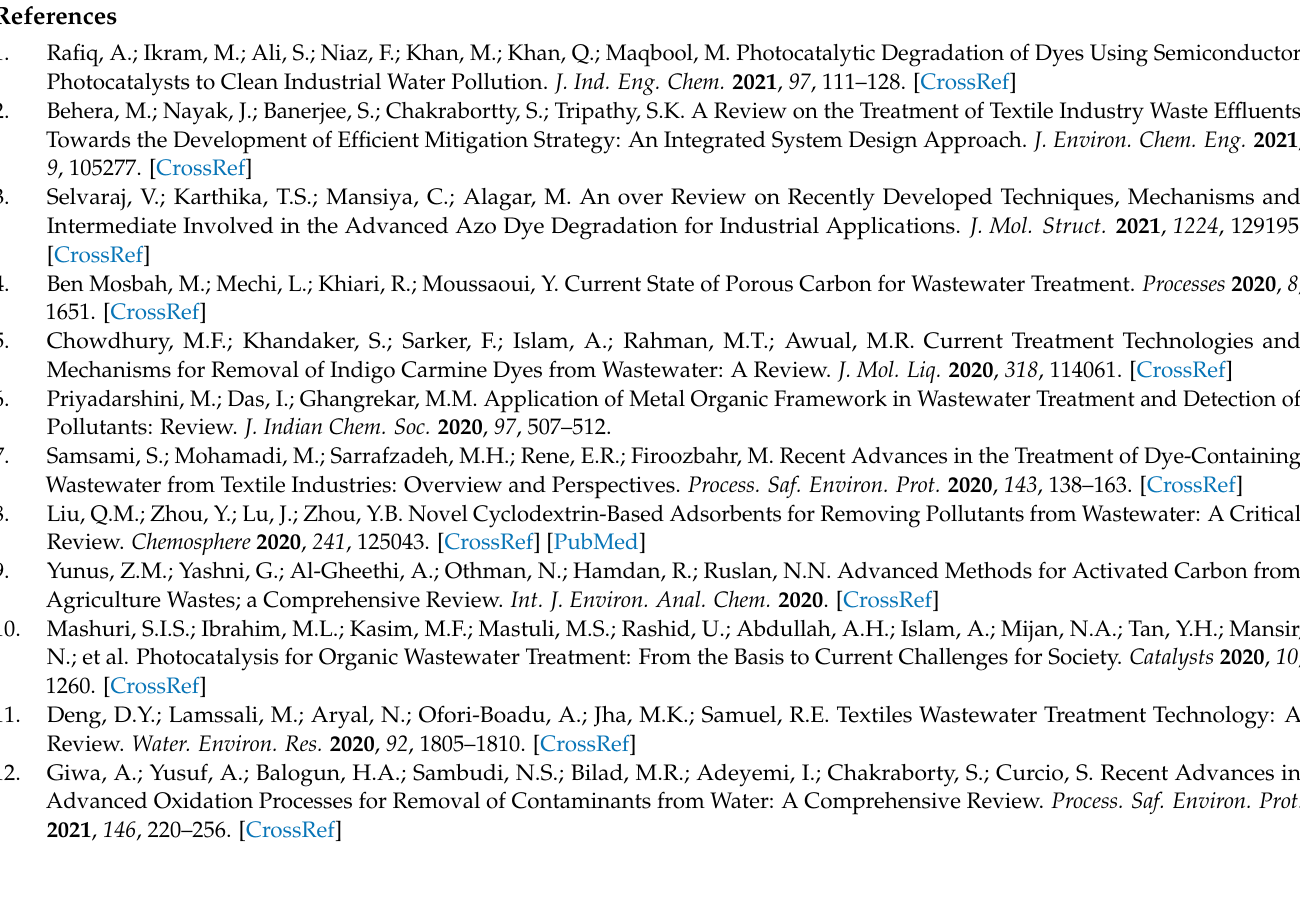
Figure A2. Degradation of MB (C/C 0 ) over time in the absence of catalyst (black), and the presence of CdS (red), ZnS (blue), and CdS-ZnS (olive) nanoparticles under visible light irradiation.